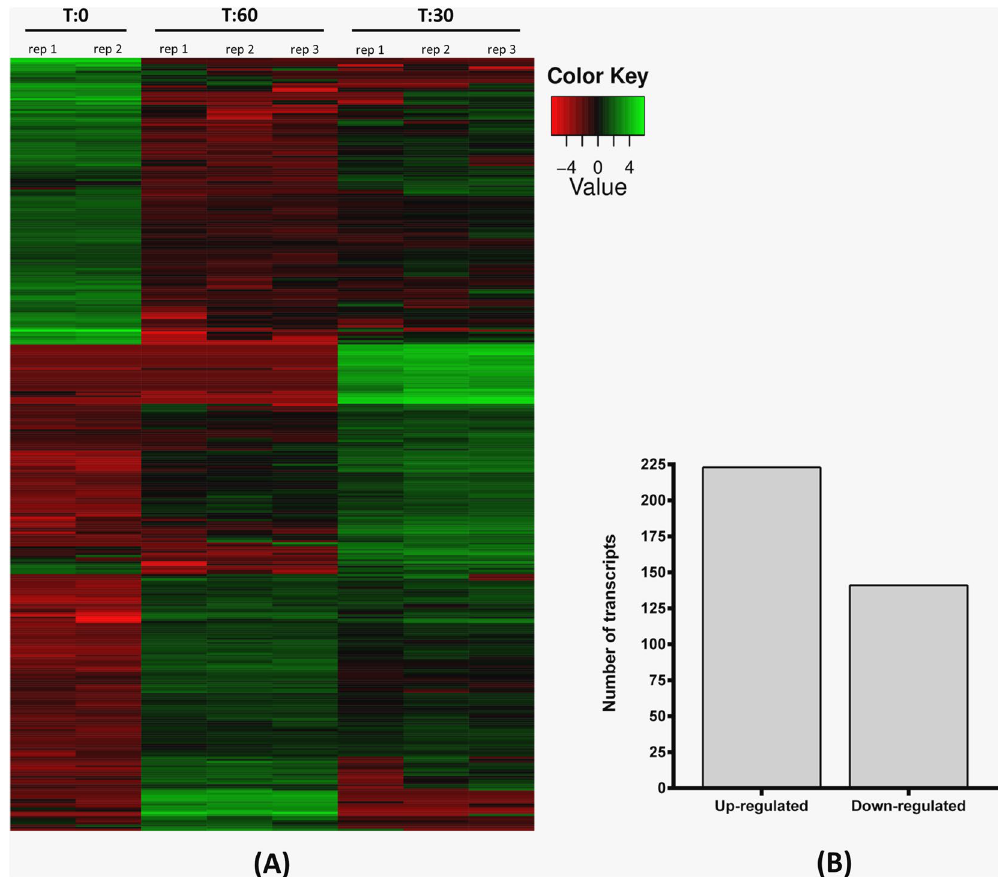
Figure 4. ( A ) Clustered heatmap showing the differential regulation (FDR ≤ 0.001) of 364 genes in response to mechanical wounding in D. cymosum . Green indicates up-regulation while red indicates down-regulation. ( B ) Of the 364 DEGs detected, 223 were up-regulated and 141 were down-regulated.